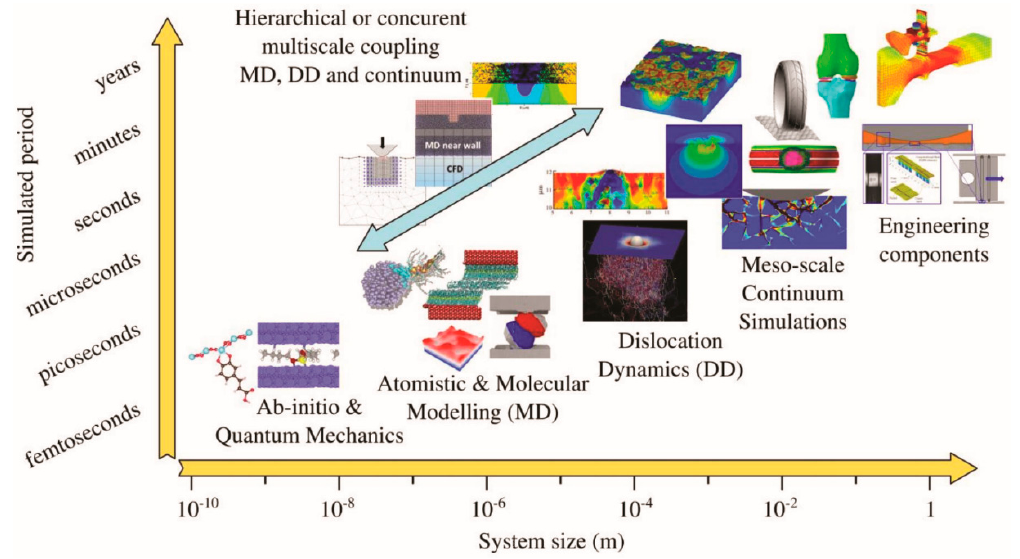
Figure 11. A time versus length scales map of models developed in tribology highlighting the intrinsic link between multiscale / physics [15]. This figure was taken from Reference [15] with due permission from the publisher.